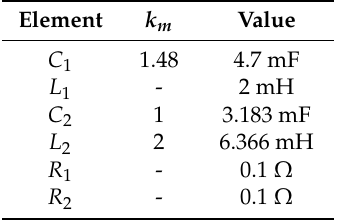
Table 3. Optimized filter elements parameter value.